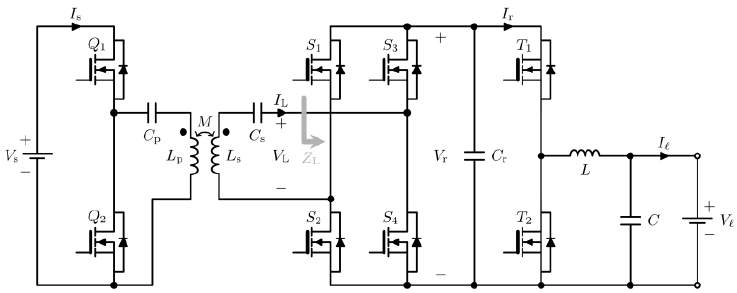
Figure 4. S–S IPTS with active rectifier and buck post-regulator [18]. Figure 4. S – S IPTS with active rectifier and buck post-regulator [18]. Figure 4. S – S IPTS with active rectifier and buck post-regulator [18].